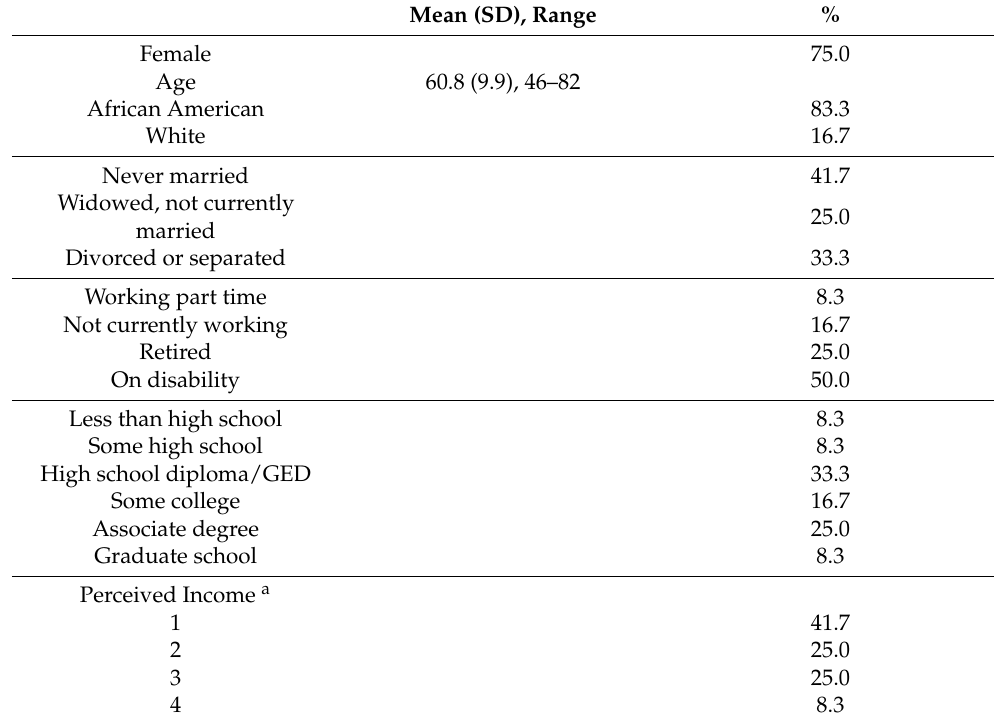
Table 1. Characteristics of TRIP Riders (N = 12).